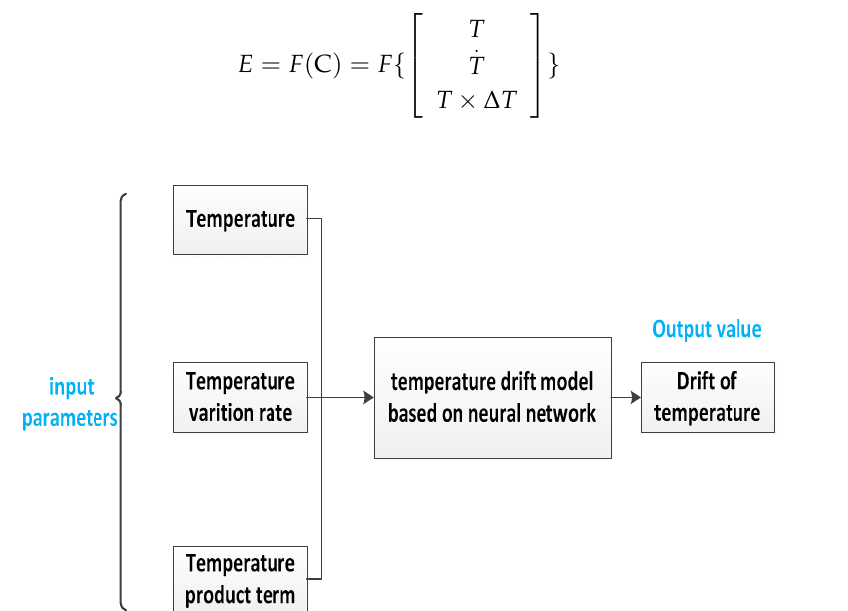
Figure 4. The framework of the temperature drift model .